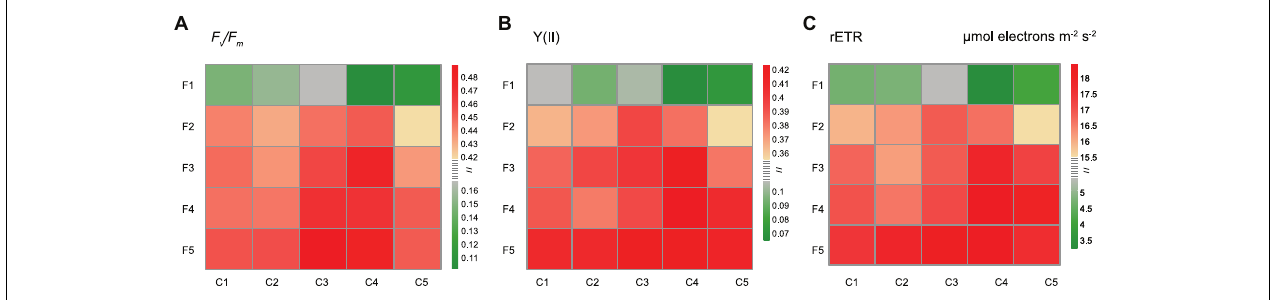
FIGURE 2 | Effects of different copper and iron concentrations on the chlorophyll fluorescence of Synechocystis sp. PCC 6803. (A) F v /F m (the maximum quantum yield of PSII); (B) Y(II) (the actual effective quantum yield of PSII); (C) rETR (the relative electron transfer